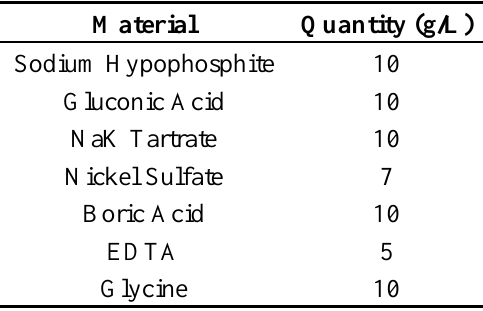
Table 1. Composition of electroless Ni-P solution.